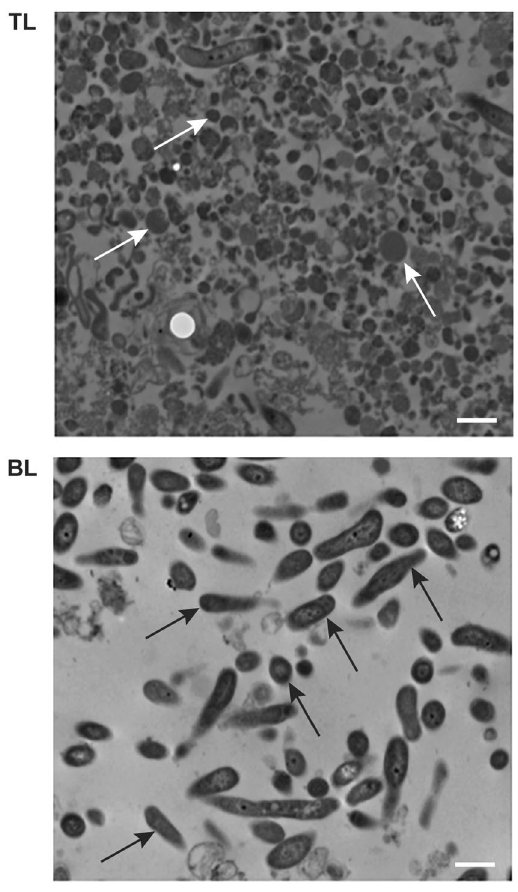
Figure 3. Transmission electron microscopy (TEM) analysis to define the E . chaffeensis organisms present in TL and BL. TEM images of the top ( A ) and bottom ( B ) layers where prototypical small DCs and pleomorphic RCs of E . chaffeensis were observed, respectively, throughout the images (a few DC and RC are identified with arrows). (Scale bars = 1 μ